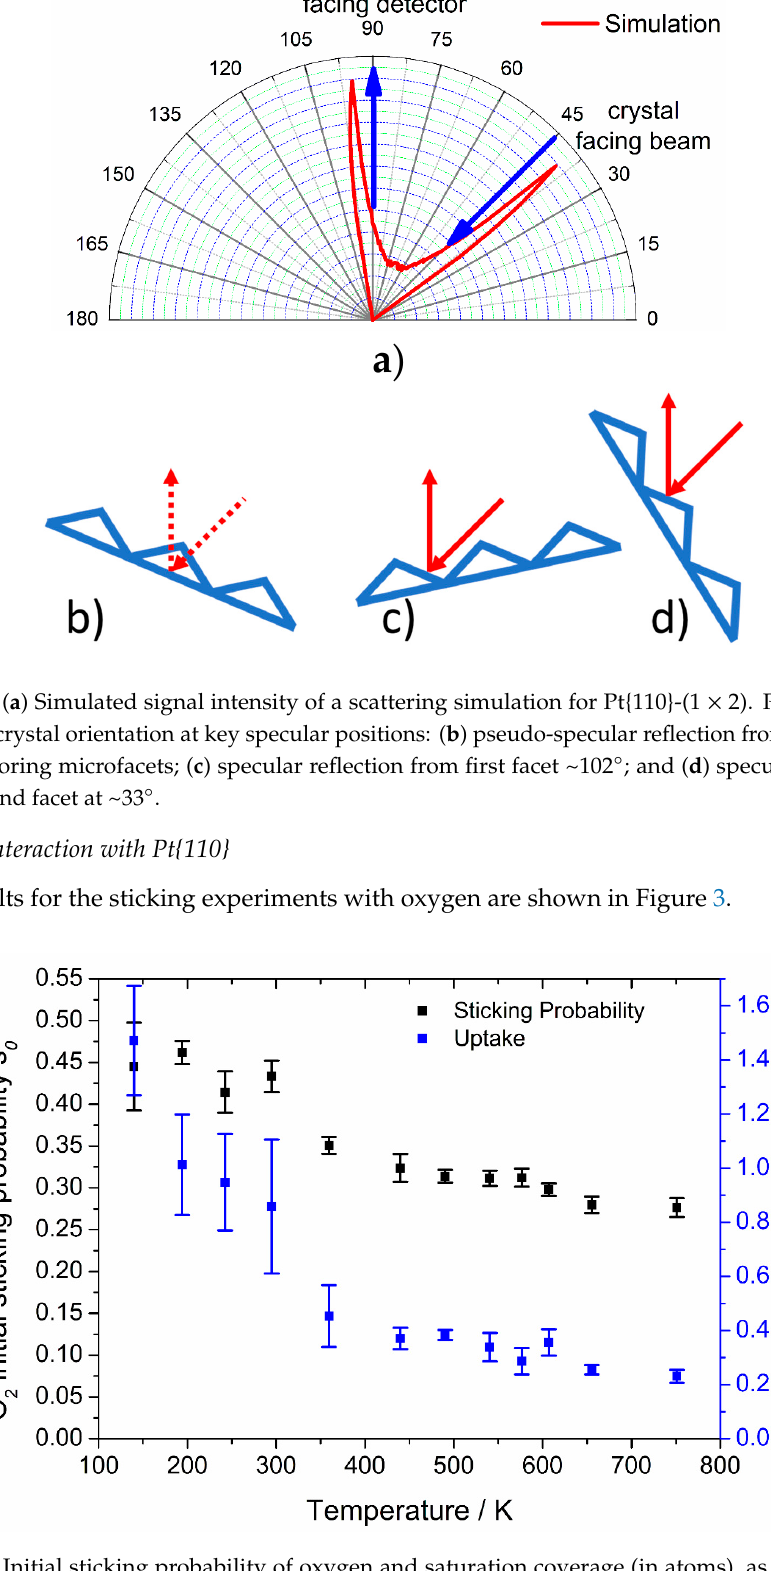
( b ) Figure 1. ( a ) Polar representation of the scattering of He and Ar from Pt(110), clearly showing the differences between the light and heavy inert gases. The latter has a much longer residence time on the surface and so becomes largely thermalized to the surface temperature. ( b ) The signal intensity is plotted as a function of crystal polar angle (Cartesian plot). For comparison with the experiment, we simulated the scattering at the surface. The Pt{110}-(1 × 2) surface was modeled by assuming a cosine-shaped hard surface potential (Figure 2). The size of the scattered atoms has been neglected, and only fully elastic scattering has been assumed (“billiard